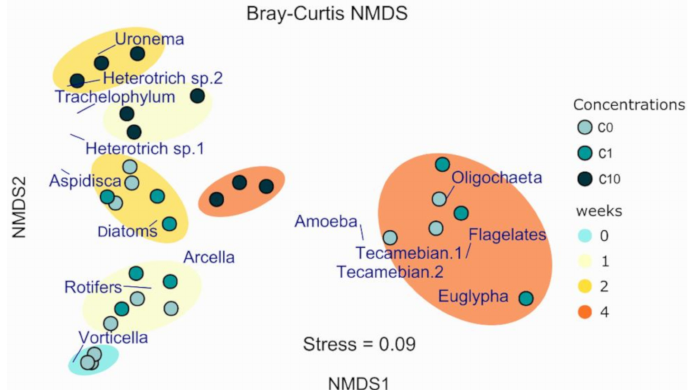
Figure 6. Ordination (non-metric multidimensional scaling (NMDS)) of the biofilm community in control (C0 = 0.2 ± 0.1 nM) and Zr exposures (C1 = 0.5 ± 0.3 nM and C10 = 2.9 ± 0.3